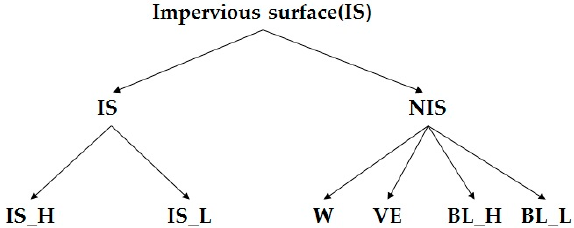
Figure 5. The frame of discernment Θ = {IS_H, IS_L, W, VE, BL_H, and BL_L}.